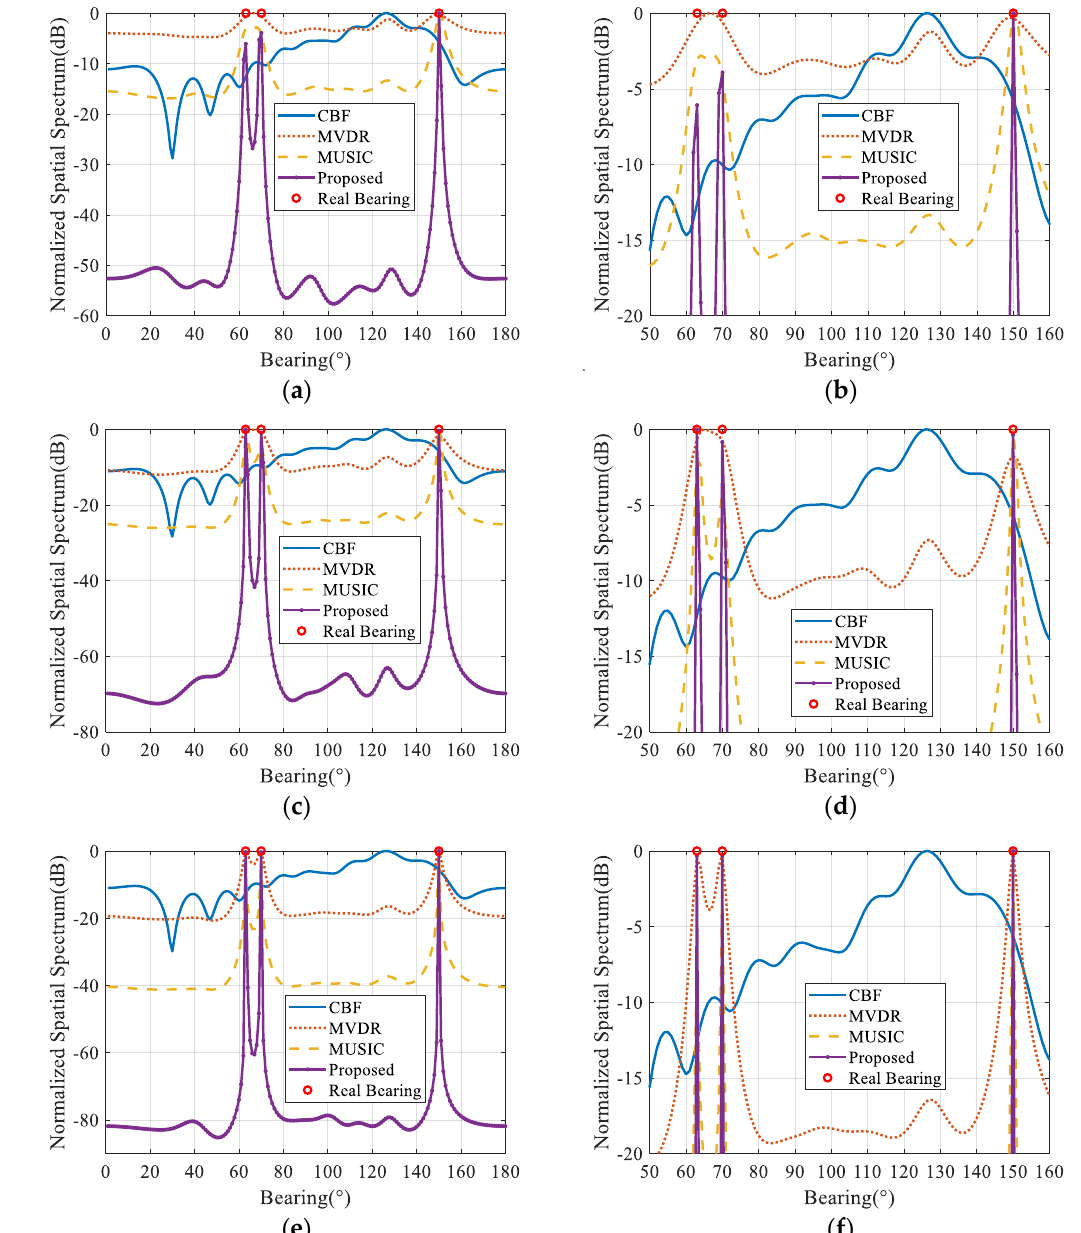
Figure 3. Spatial spectra under different signal-to-noise ratio (SNR) at interference-to-noise ratio (INR) of 50 dB. ( a , c , e ) Normalized spatial spectrum of conventional beamforming (CBF), Minimum Variance Distortionless Response (MVDR), Multiple Signal Classification (MUSIC), and the proposed method at SNR of − 10 dB, 0 dB, and 10 dB, respectively; ( b , d , f ) partial enlargement at SNR of − 10 dB, 0 dB, and 10 dB, respectively. Red hollow circles represent the real arrivals of far-field signals.